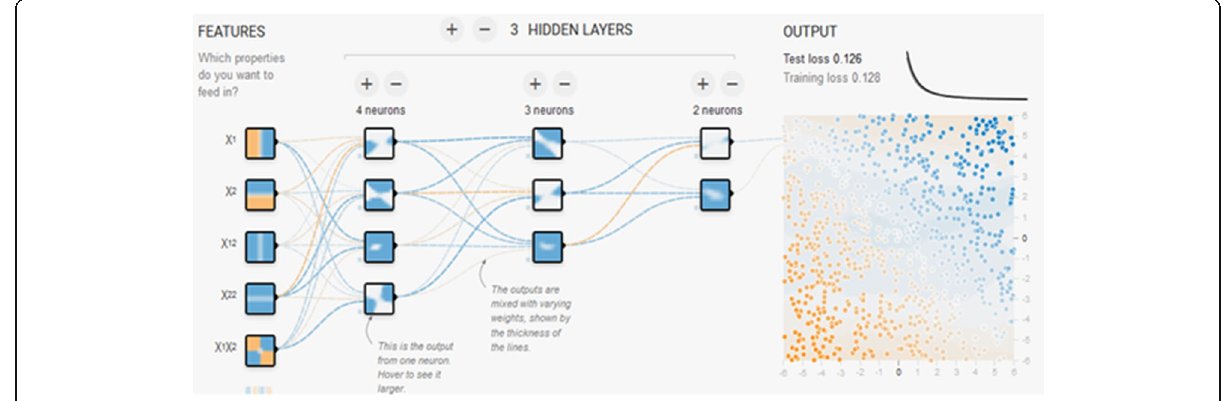
Fig. 7 Initial stage of learning the data in ANN